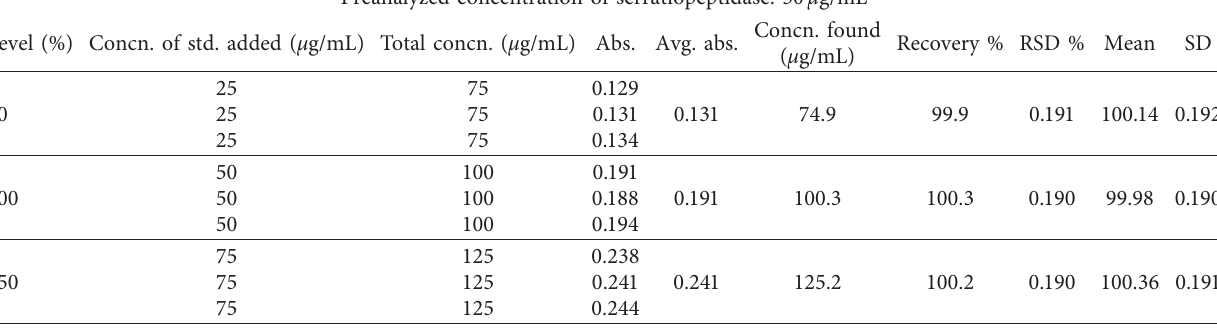
Table 2: Accuracy analysis of SRP.